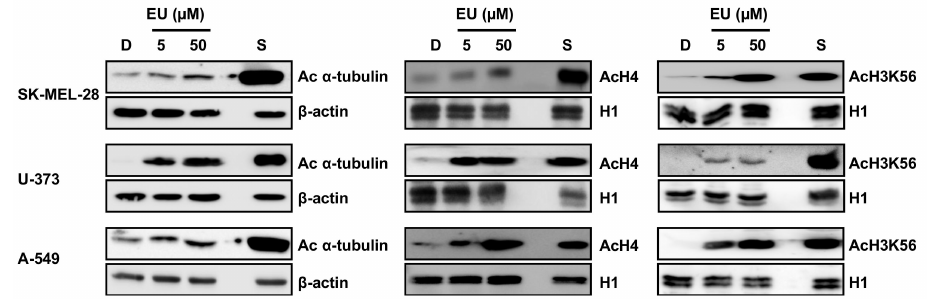
Figure 5. Effect of eurochevalierine on the acetylation status of sirtuin targets. SK-MEL-28, U-373, and A-549 cells were treated with 5 and 50 µ M eurochevalierine (EU) for 8 h. Acetylation of histone H4 (AcH4), histone H3 at lysine 56 (AcH3K56), and α -tubulin (Ac α -tubulin) was analyzed via Western blot. β -actin and histone H1 were used as loading controls for the analysis of total and acid extracts, respectively. SAHA (S, 1 µ M) was used as a reference HDAC inhibitor. Blots are representative of three independent experiments.